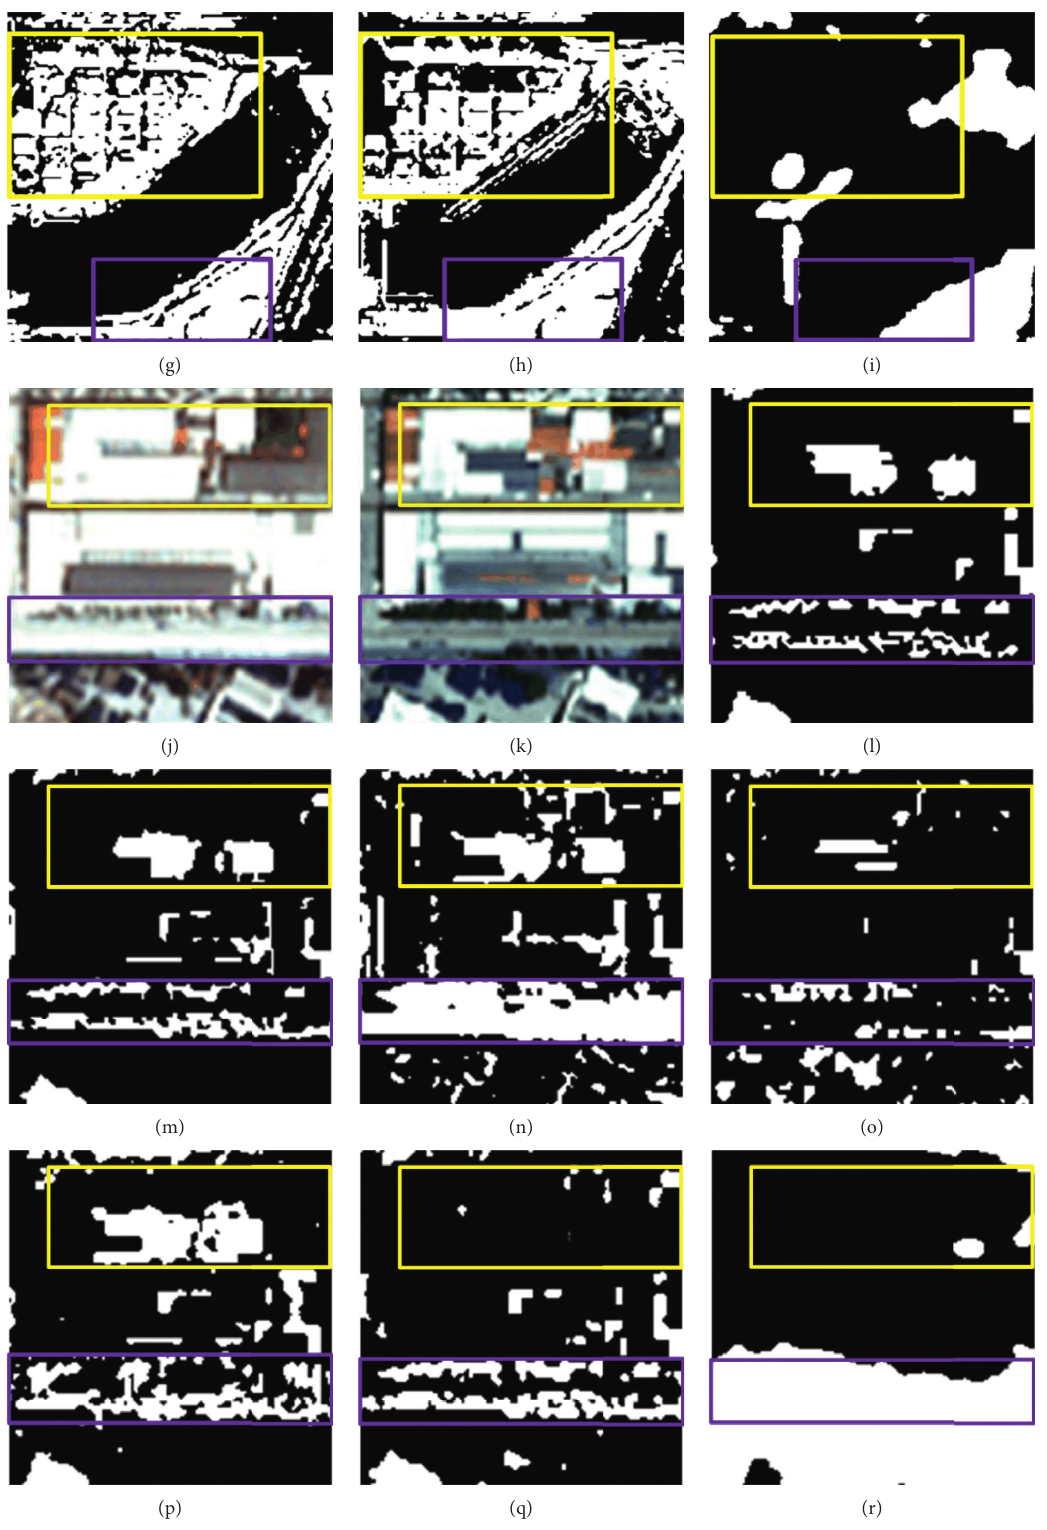
Figure 7: CD maps of patches I3 and I4: (a-b) patch I3; (c) reference map of Patch I3; (d–i) CD maps obtained in patch I3 using the proposed method and Methods 1, 2, 3, 4, and 5, respectively; (j-k) patch I4; (l) reference map of patch I4; (m–r) CD maps obtained in patch I4 using the proposed method and Methods 1, 2, 3, 4, and 5,